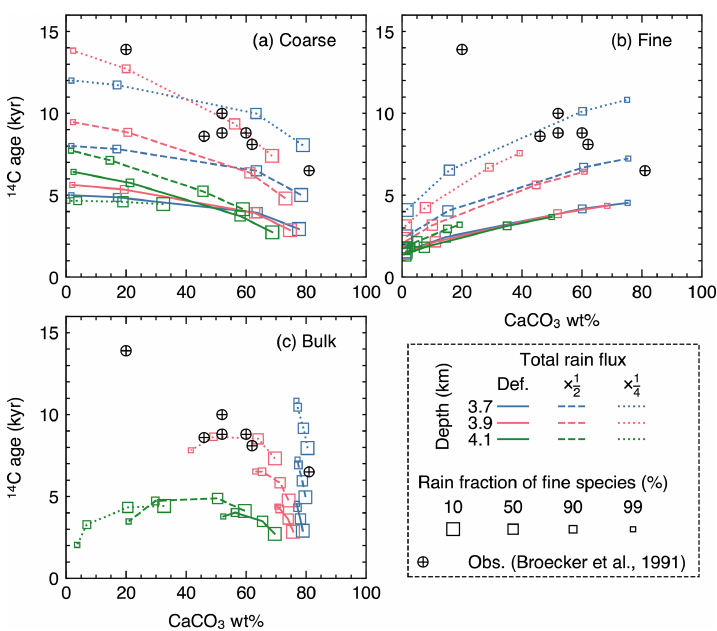
Figure 16. Radiocarbon ages plotted against CaCO 3 wt% in the mixed layer for (a) coarse and (b) fine CaCO 3 species, and (c) bulk CaCO 3 . The values at 12cm sediment depth are assumed to represent those in the mixed